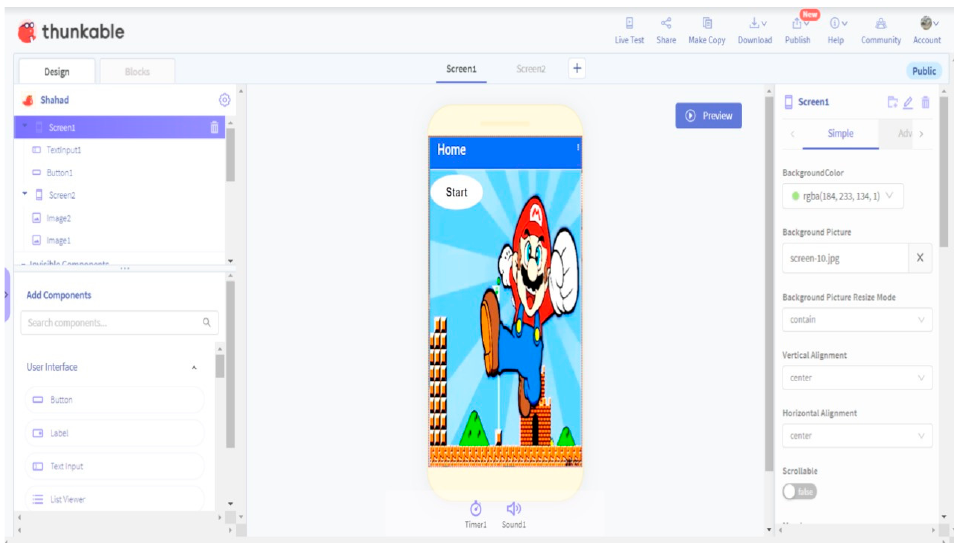
Figure 2. Thunkable user interface.